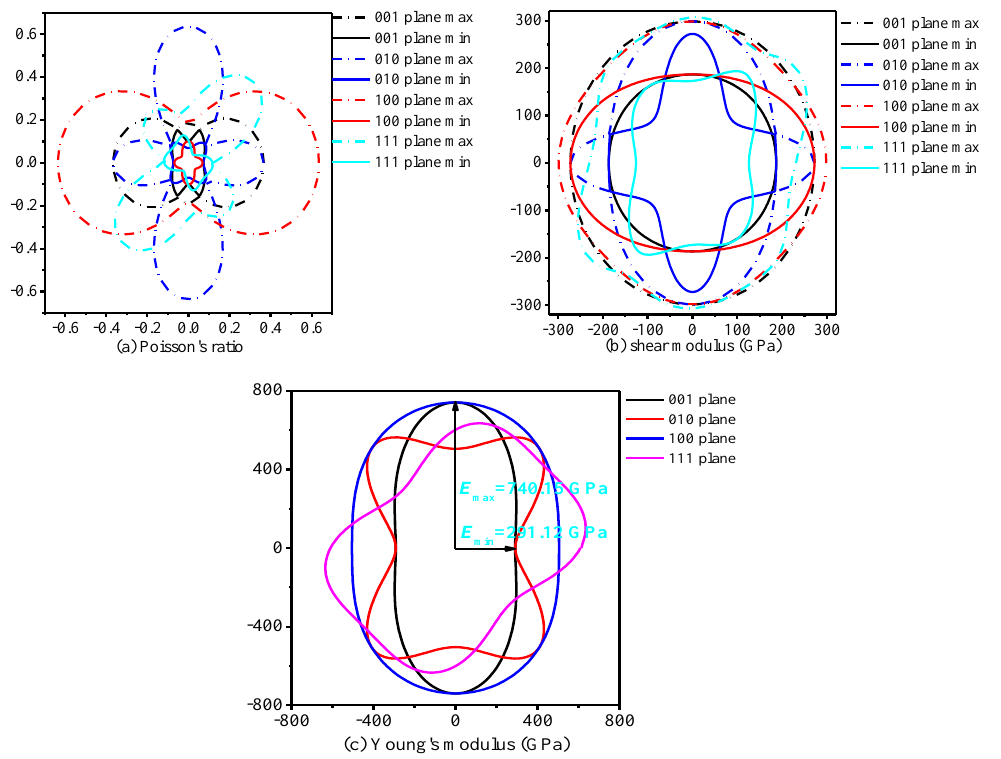
Figure 6. 2D representation of Poisson’s ratio ( a ); shear modulus ( b ) and Young’s modulus ( c ) in the main plane for Pnma -BN, respectively.